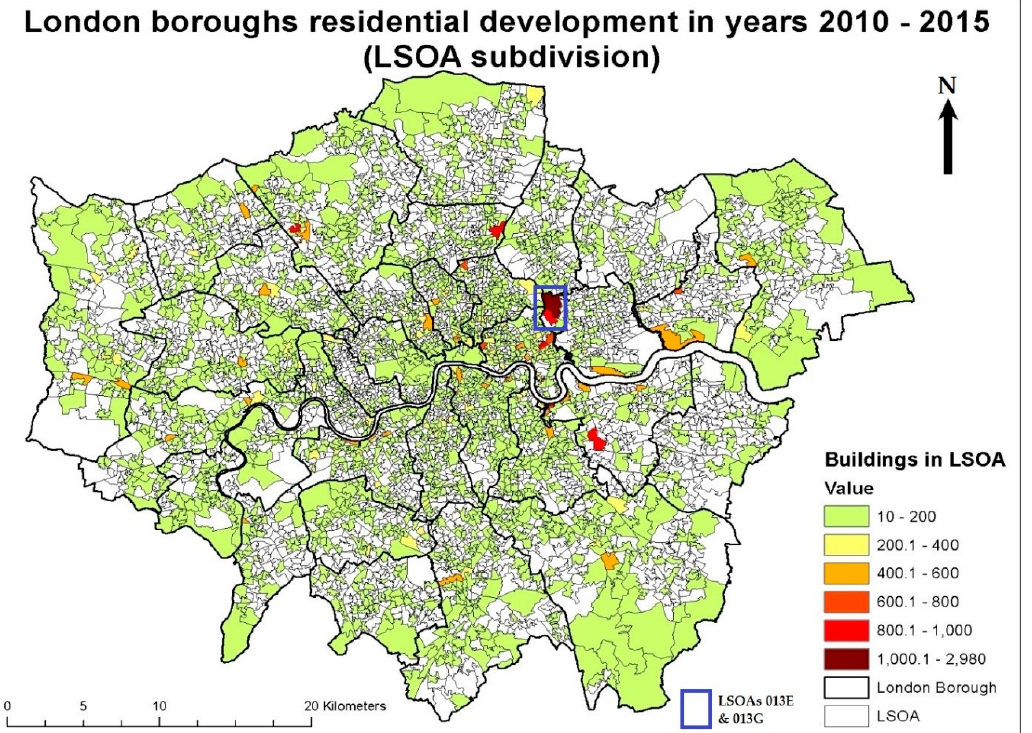
Figure 2. Map of London boroughs residential development in years 2010–2015 (Lower Super Output Area (LSOA) subdivision). LSOAs 013G and 013E within Newham borough are highlighted in blue. Contains National Statistics data © Crown copyright and database right (2015) and (2012). Contains Ordnance Survey data © Crown copyright and database right (2015) and (2012).